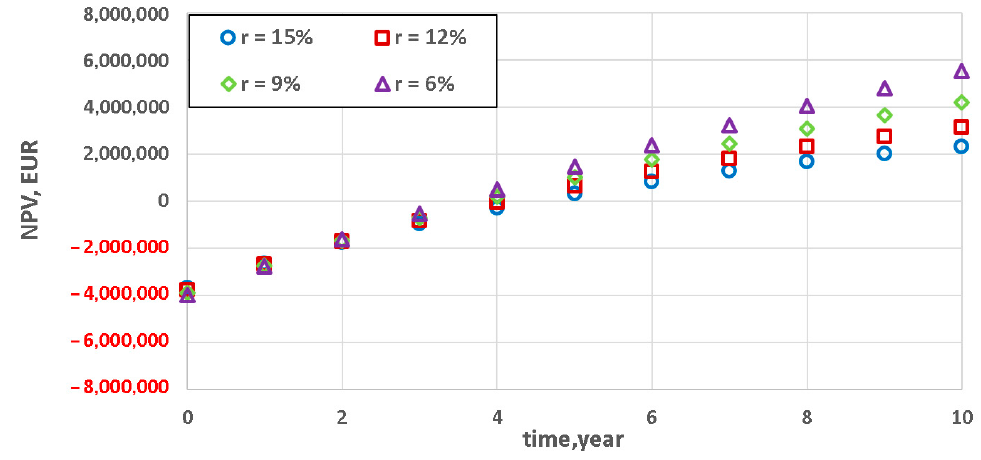
Figure 8. Results of NPV analysis for different values of the expected rate of return (for power unit technical minimum amounting to 30% of the rated power, Y = 1).